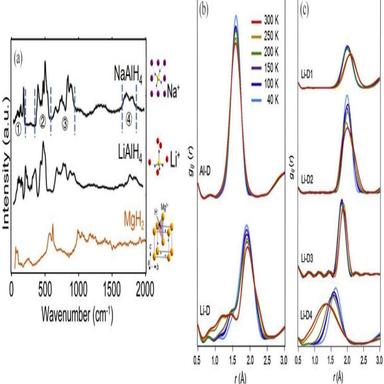
(a) INS spectra of NaAlH4 and LiAlH4 with comparison of MgH2. As for the INS spectra of NaAlH4, four regions are noted corresponding to the external motions of - :1) < 194 cm−1: translation modes, 2) 350–550 cm−1: complex anion libration modes, and the internal motions of - , 3) 600–900 cm−1: H-Al-H bending modes, and 4) 1750–1815 cm−1: Al–H stretching modes. The local atomic arrangements around - and the crystal structure of MgH2 are on the right; (b) Partial pair distribution gij(r) of Al